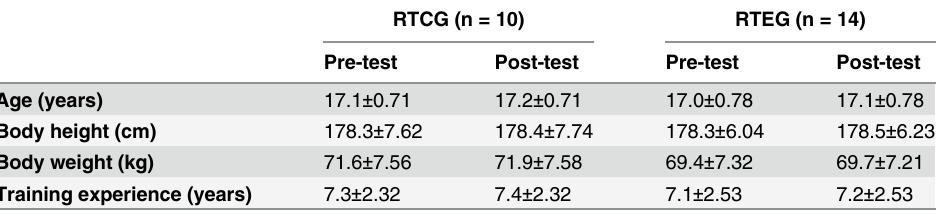
Table 1. Physical characteristics and training experience of the subjects * (mean values ±